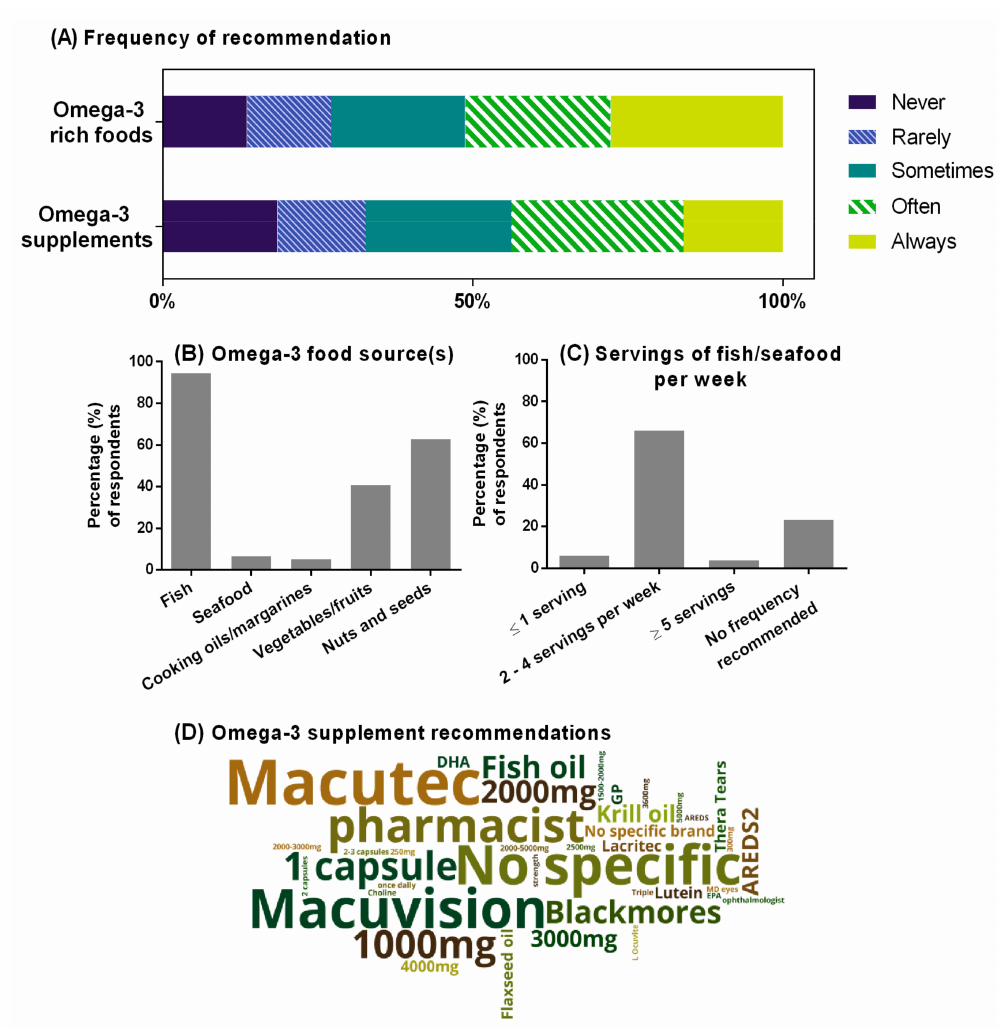
Figure 3. Optometrists’ self-reported clinical practices as related to omega-3 fatty acid intake as a componentofAMDmanagement. ( A